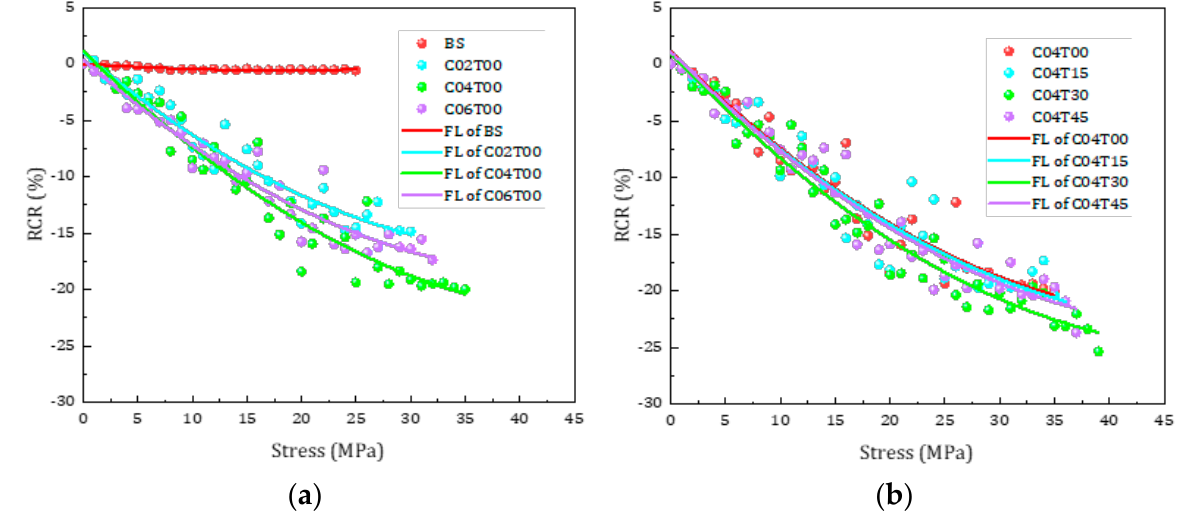
Figure 9. Stress–RCR fitting curves of cement-based composites under 150 freeze-thaw cycles. ( a ) Stress–RCR curves of BC, C 02 T 00 , C 04 T 00 , C 06 T 00 , ( b ) stress-RCR curves of C 04 T 00 , C 04 T 15 , C 04 T 30 , C 04 T 45 .